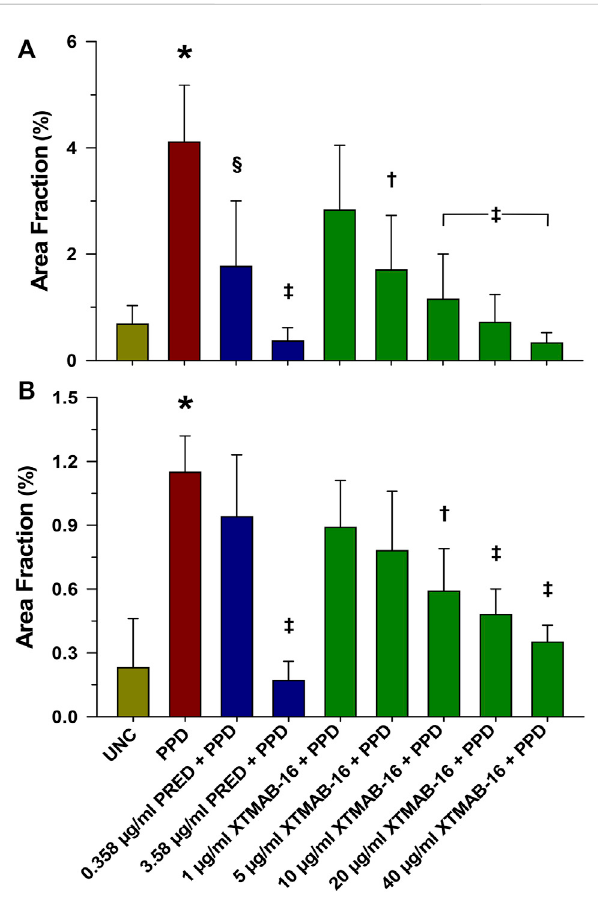
FIGURE 1 Group Analysis of Granuloma Formation Represented as Area Fraction in High Responder (A) , and Low Responder (B) Patients With Sarcoidosis.Note: n =6forthehighrespondergroup,and n =4forthe low responder group; * p < 0.001, compared to the uncoated bead (UNC) treatment group; † p < 0.01, ‡ p < 0.001, and § p < 0.05 relative to the PPD-treated group. Area Fraction = cumulative granulomaareaasapercentageofthetotalareaoftheimage.Barsare mean (percent) ± SD. Abbreviations: PPD = puri fi ed protein derivative; PRED = prednisone; SD = standard deviation; UNC = uncoated beads.